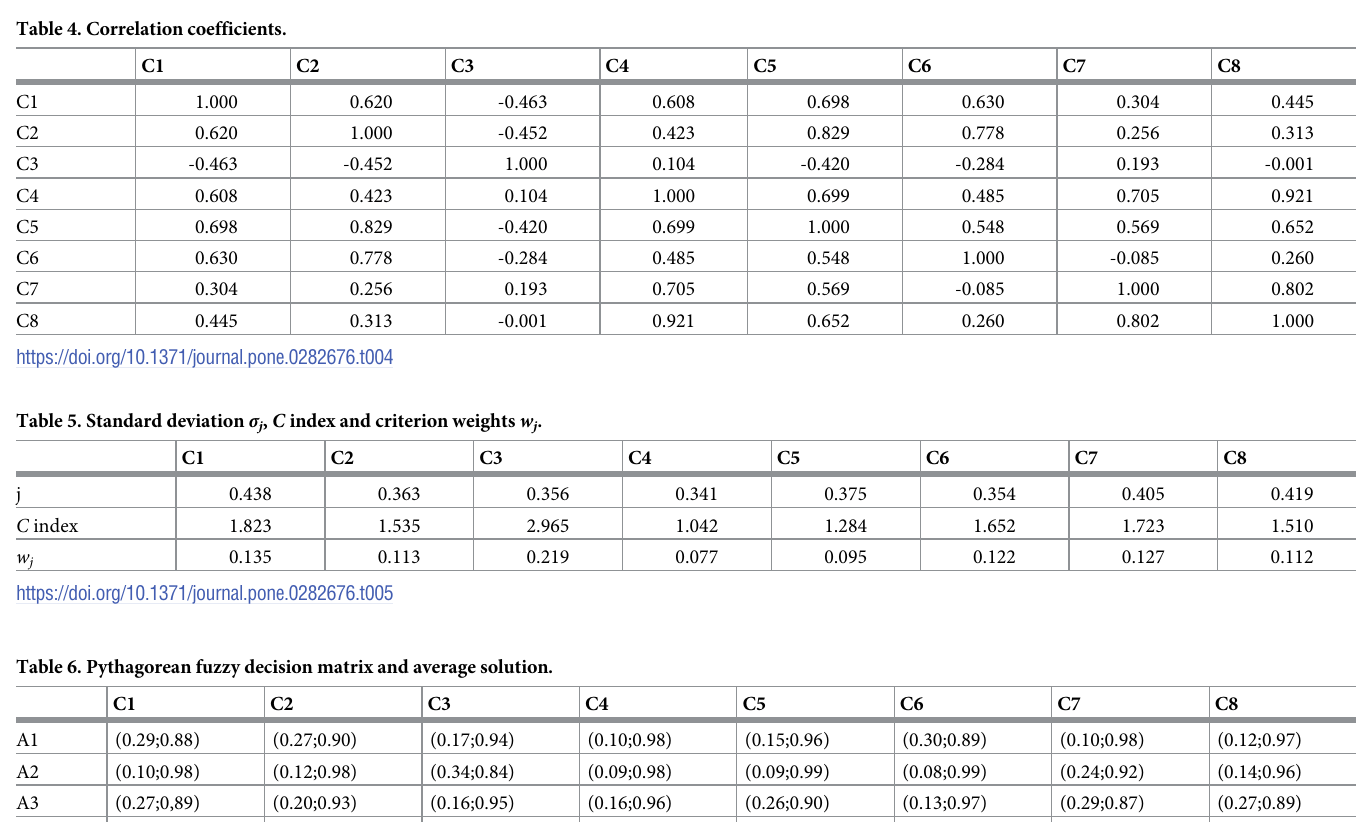
Table 4. Correlation coefficients.